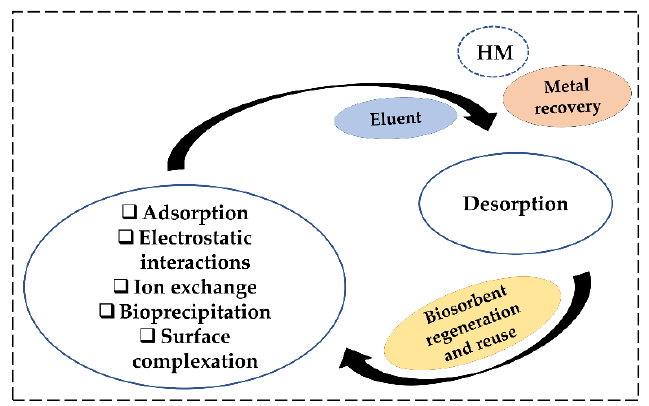
Figure 4. Sorption-desorption mechanism for heavy metals (HM) removal from wastewaters using microbial biosorbents.